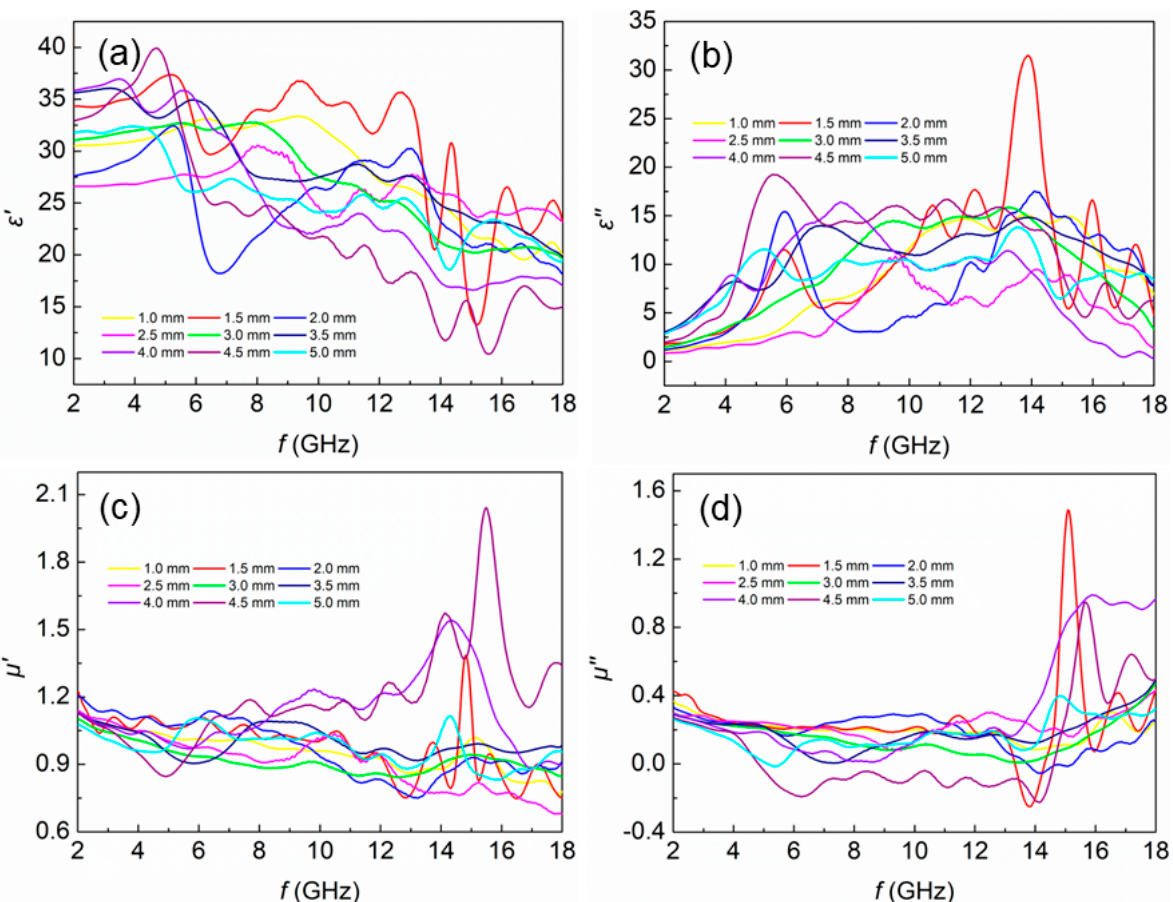
Figure 5. Frequency dependence of electromagnetic parameters of as–prepared FeSiBNi2 metallic microwires when the mass ratio is 50 wt.% with different thicknesses of the composite at 2–18 GHz: ( a ) ε ′ ; ( b ) ε ′′ ; ( c ) μ ′ ; ( d ) μ ′′ .